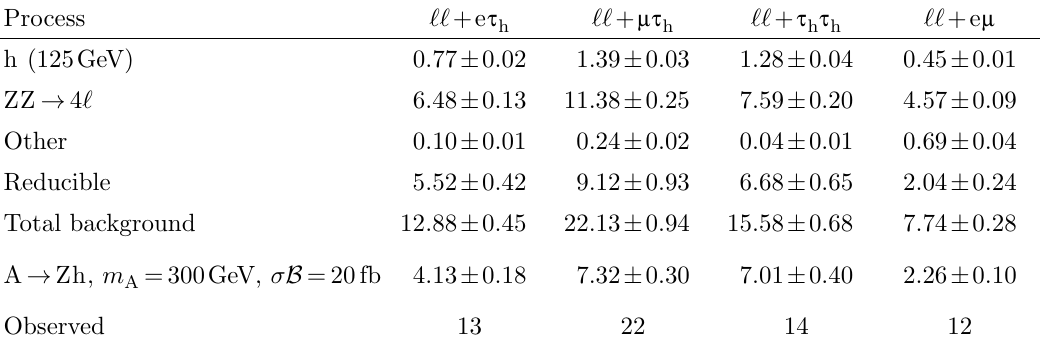
Table 4 . Background and signal expectations together with the numbers of observed events, for the signal region distributions after a background-only (cid:12)t. The expected contribution from the A ! Zh signal process is given for a pseudoscalar Higgs boson with m = 300 GeV with the product of the A cross section and branching fraction of 20 fb. The background uncertainty accounts for all sources of background uncertainty, systematic as well as statistical, after the simultaneous (cid:12)t.